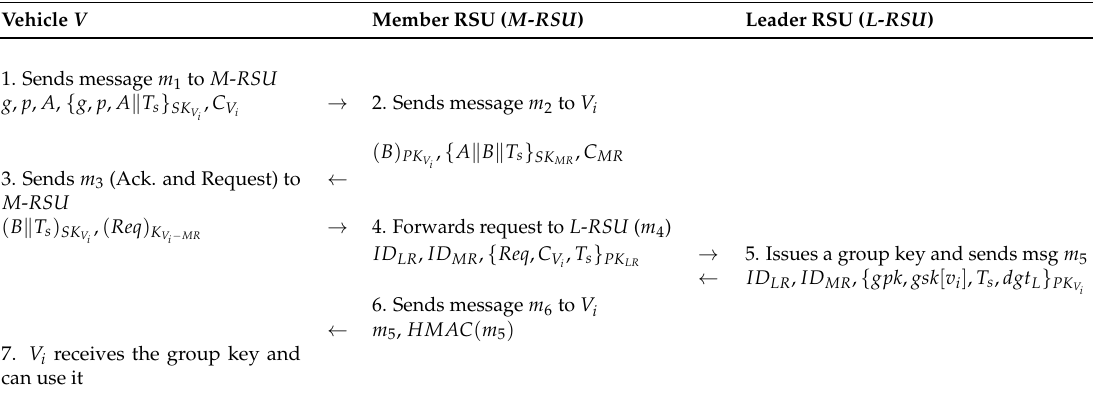
Table 2. Key establishment